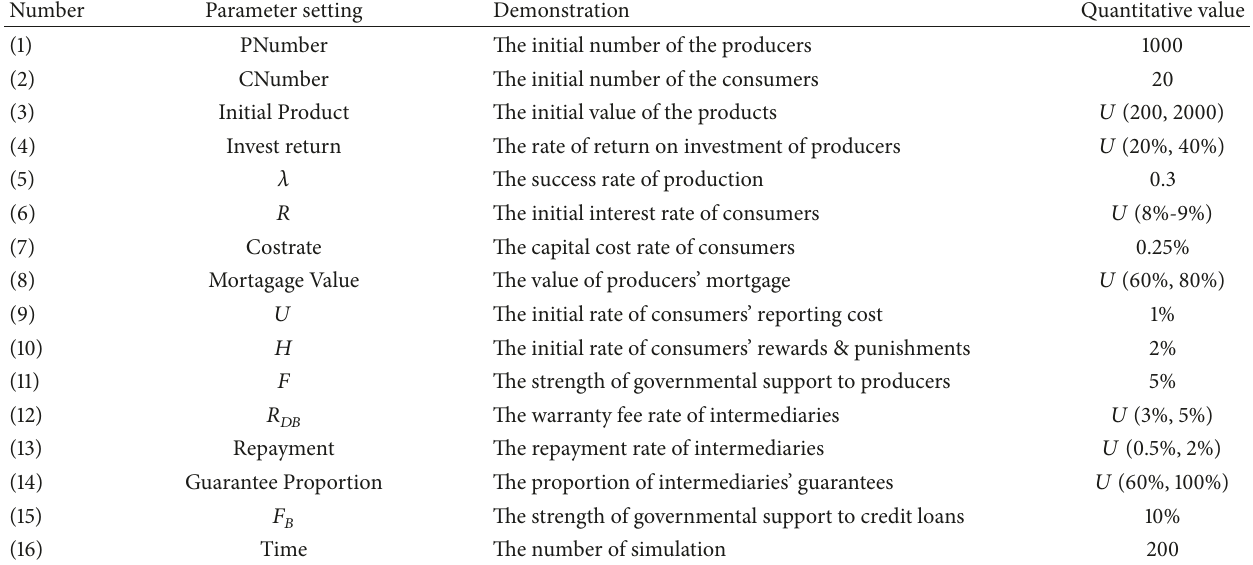
Table 3: Initial parameter settings of the